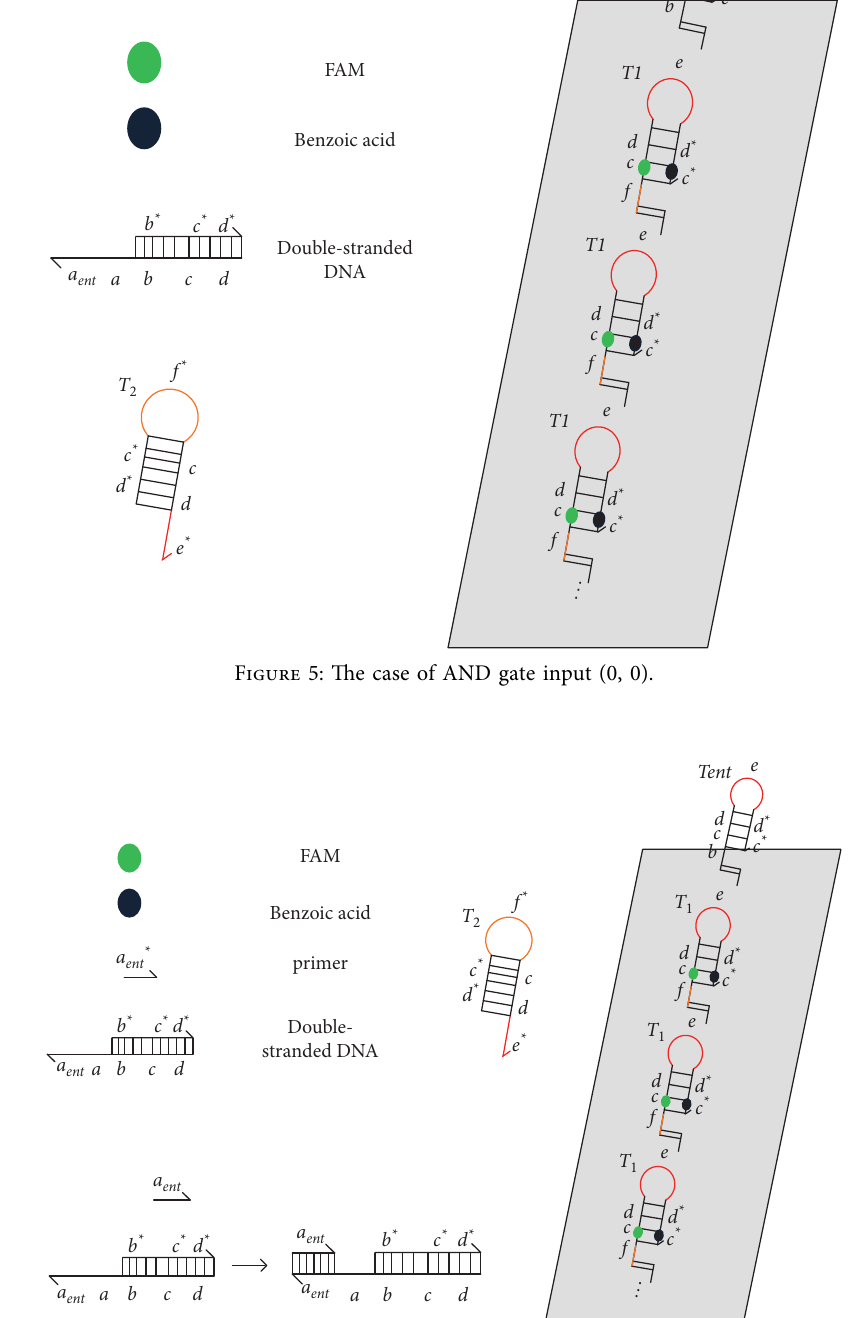
Figure 6: The case of AND gate input (1,